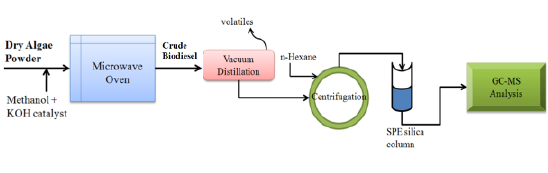
Figure 2. Algal biomass conversion scheme via microwave process